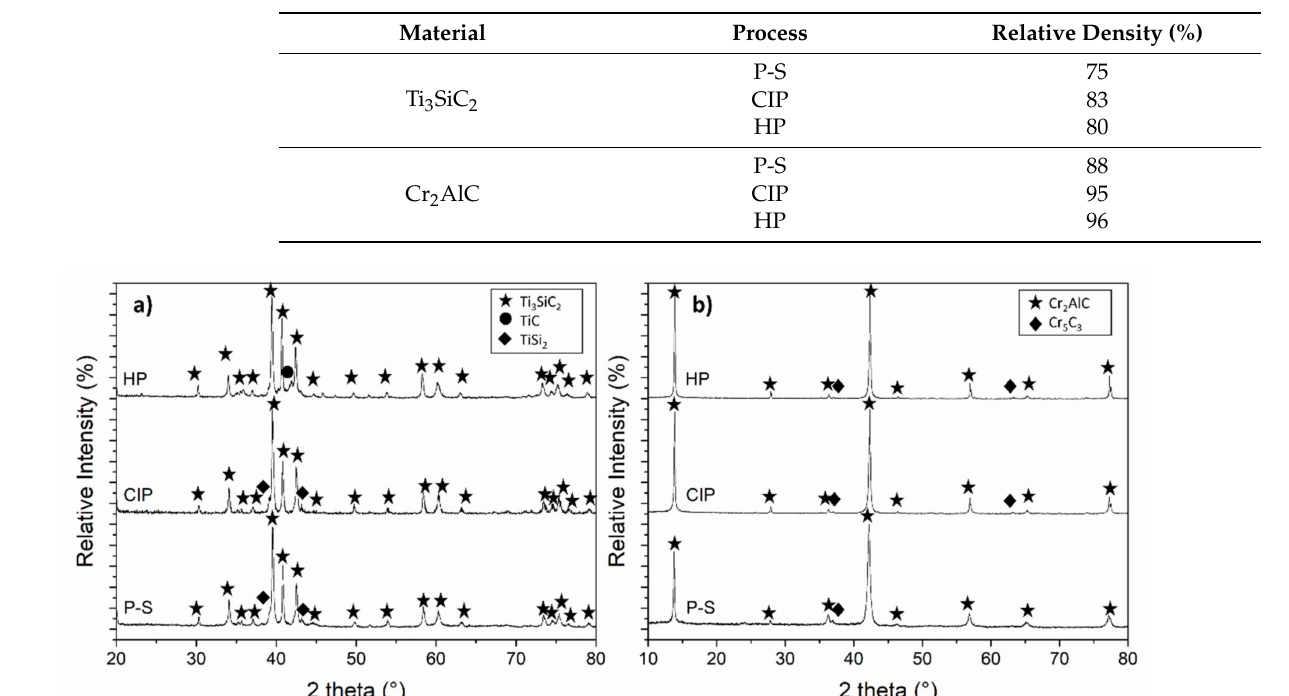
Figure 7. The X-ray diffraction patterns of uniaxially pressed and sintered (P-S), cold isostatic pressed and sintered (CIP) and hot-pressed (HP) consolidated samples after optimization of the process for ( a ) Ti 3 SiC 2 at 1150 ◦ C for 1 h and ( b ) Cr 2 AlC at 1200 ◦ C for 15